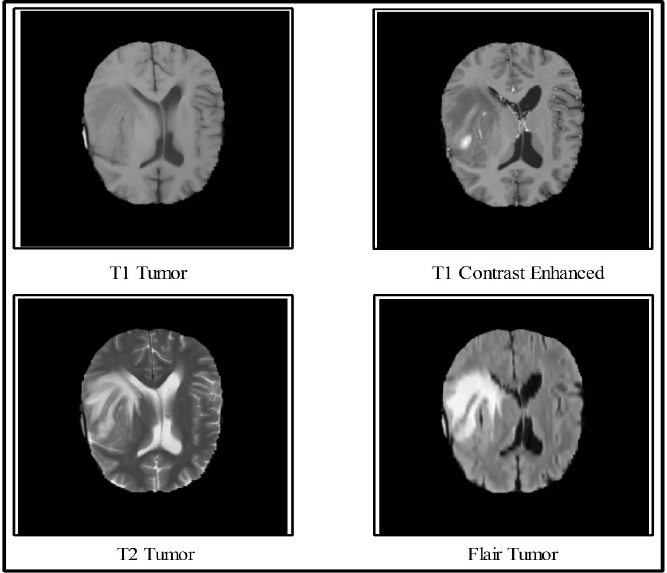
Figure 1. Sample images collected from Multimodal Brain Dataset (BRATS) [15].